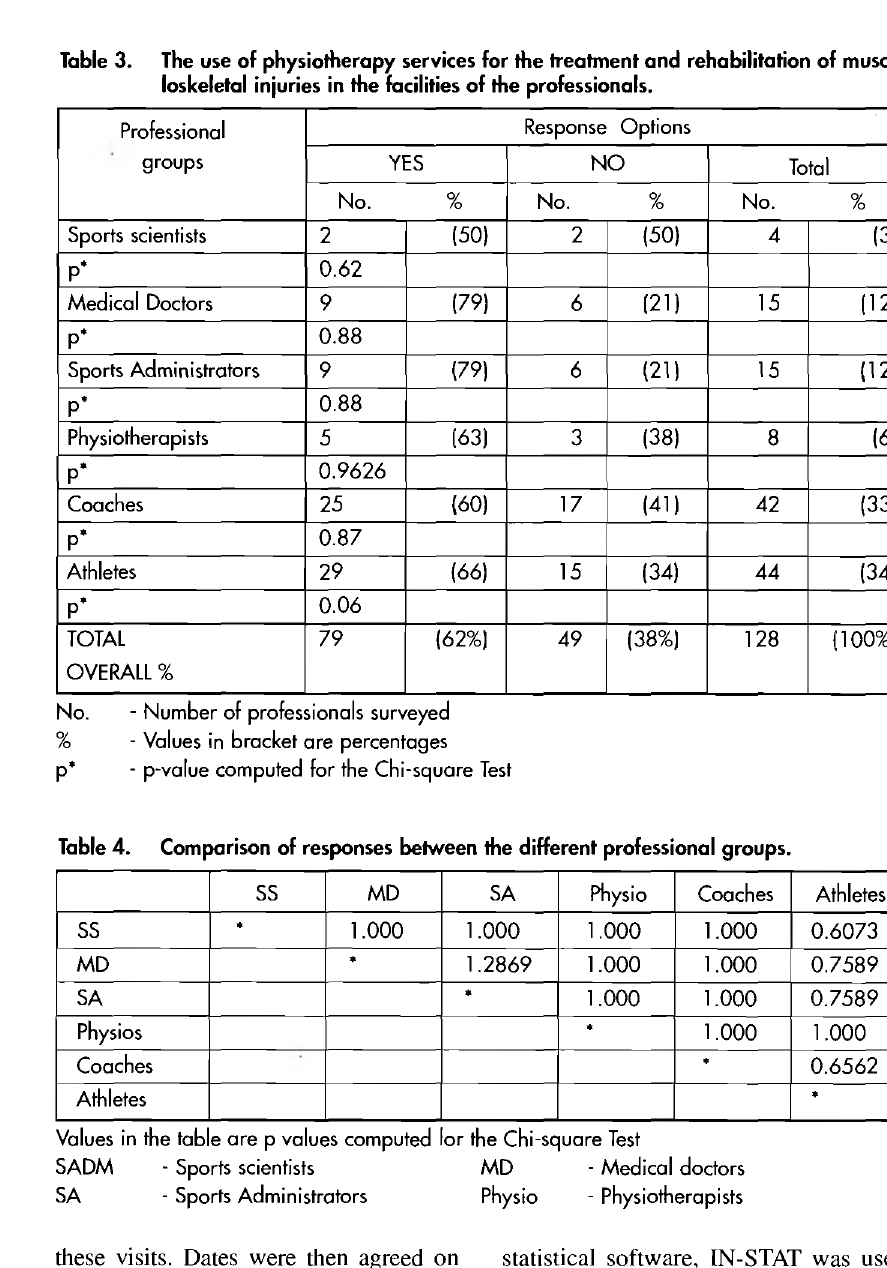
Comparison of responses between the different professional